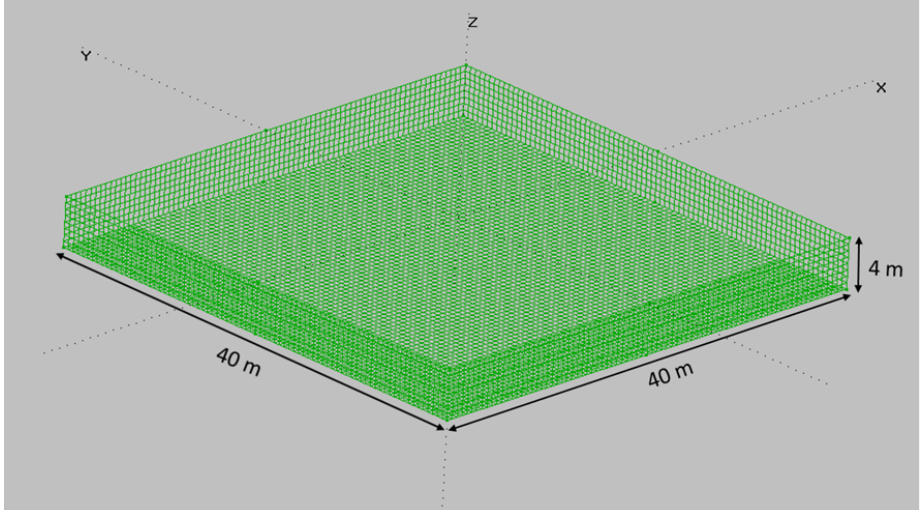
Figure 2. Geometry of the standard barge platform.